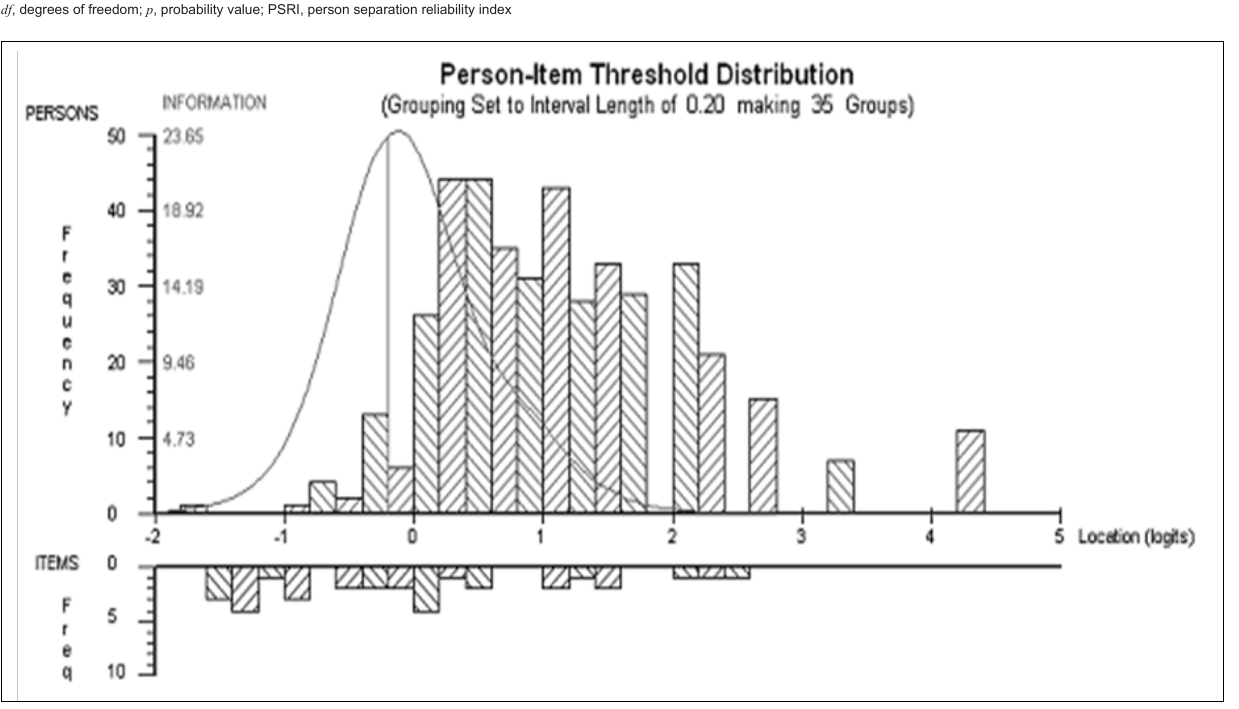
FIGURE 1 Person-item threshold distribution and information function for the Self-Directed Career Management